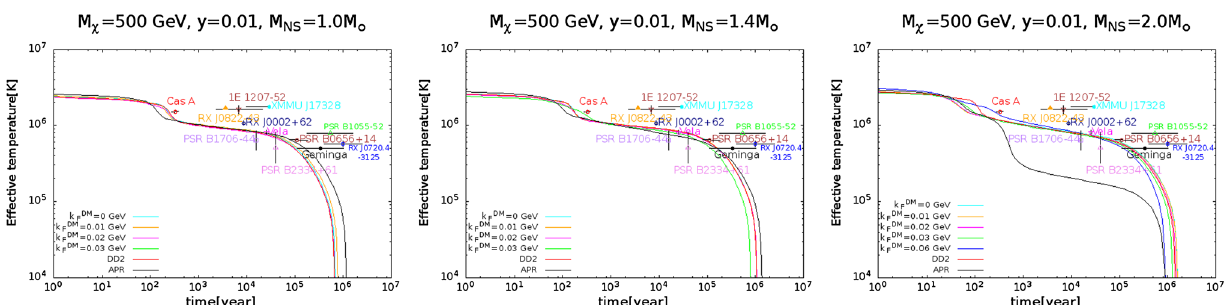
Fig. 8 Same as in Fig. 7 but for M χ = 200GeV